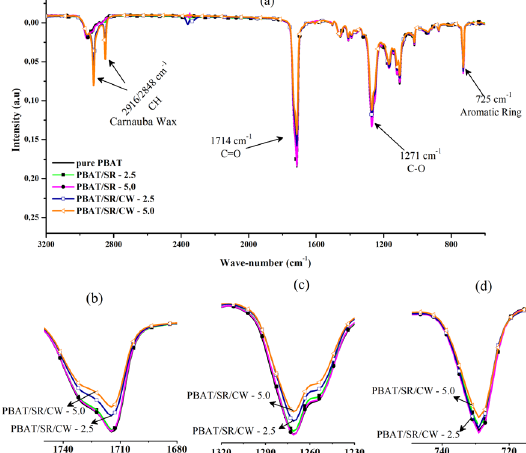
Figure 2. FTIR spectra in the 3200-800 cm -1 range of pure PBAT and mulch films (a) and PBAT bands amplifications in